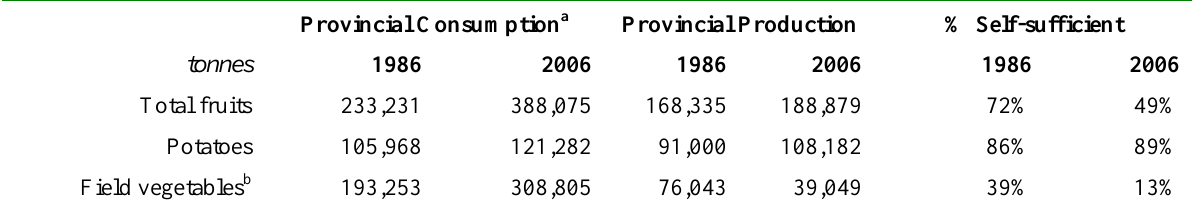
Table 7. Provincial Consumption and Production of Food, 1986 & 2006 and %